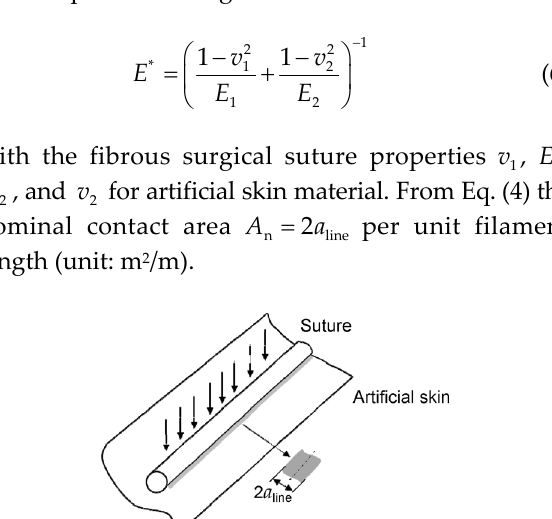
Fig. 2 Contact mechanics modelling procedure of the frictional behaviour of fibrous surgical suture contacting an artificial skin counterface.